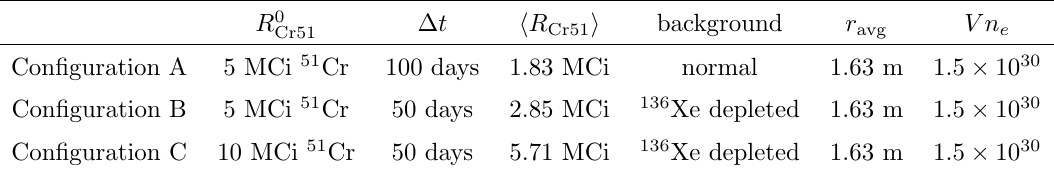
Table 1 . Con(cid:12)gurations of the 51 Cr-LXe experiment considered in this